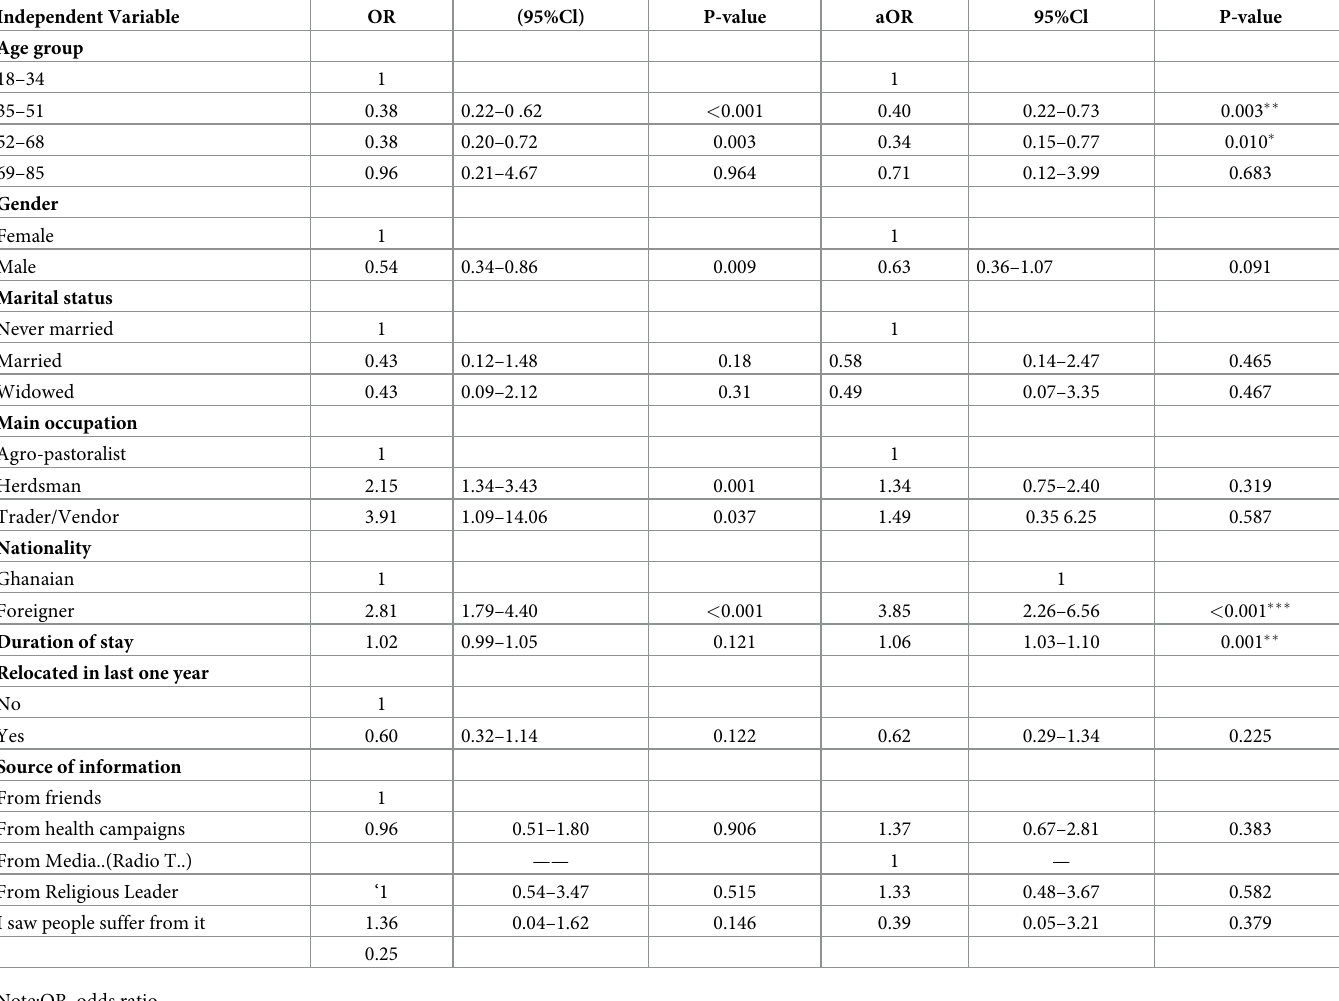
Table 6. Bivariate and multivariate logistic regression analyses showing predictors of practices towards yellow fever in the West Gonja Municipal, Ghana, 2022.